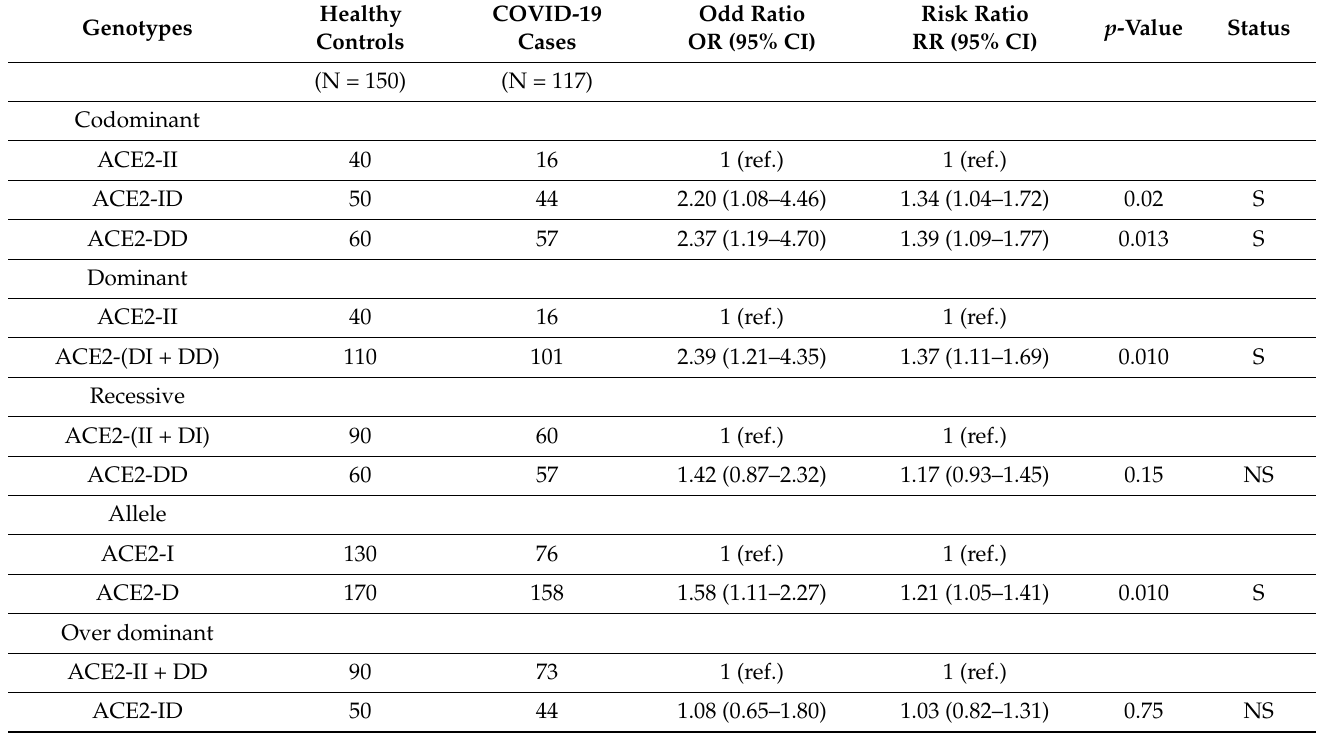
Table 4. Multivariate and ordinal regression risk factor analysis for COVID-19 severity with ACE2-rs4646994 I/D genotypes.